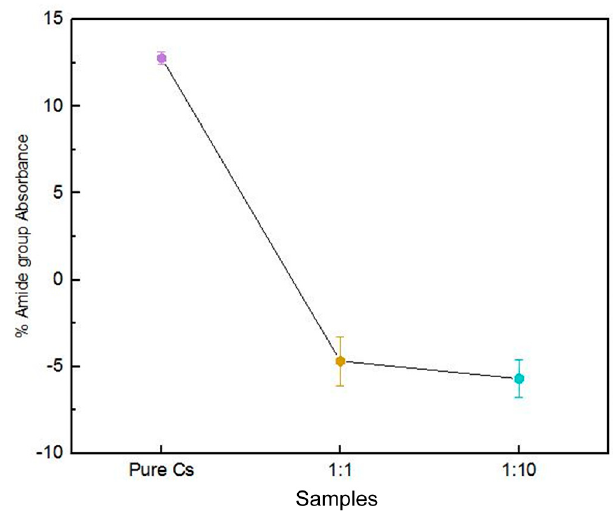
Figure 5. Amount of amide present in pure chitosan (Cs), 1:10 polyaniline–chitosan (PAni–Cs), and 1:1 PAni–Cs composites.